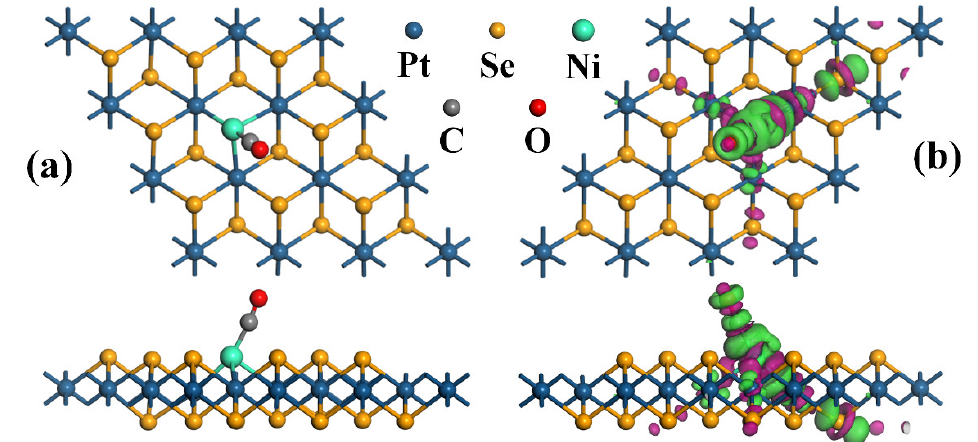
Figure 4. ( a ) The MSC, ( b ) EDD of Ni- PtSe 2 /CO system. In EDD, the green (rosy) areas indicate electron accumulation (depletion).